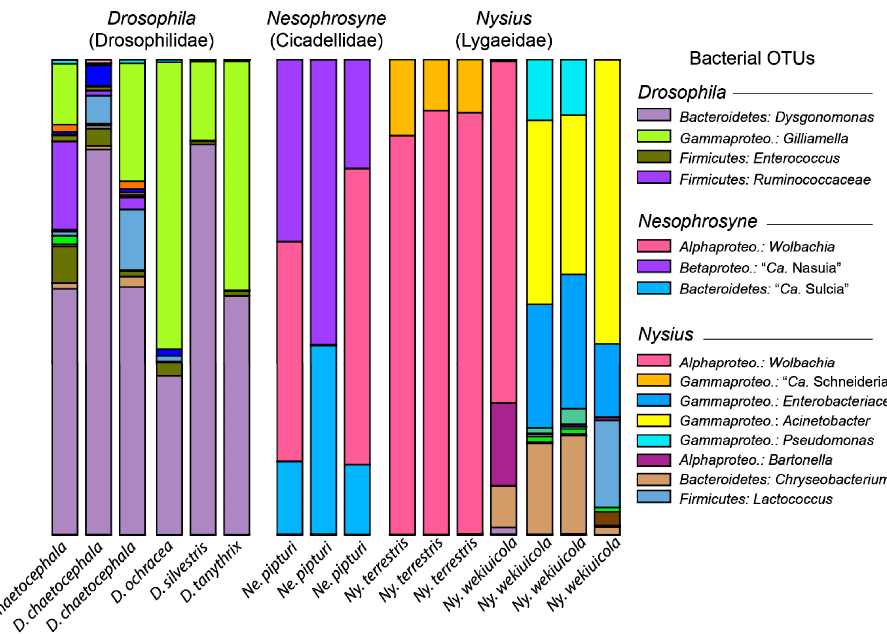
Figure 3. Relative abundance of bacterial groups observed in insects with different feeding behaviors. Different colors represent various bacterial Operational Taxonomic Units (OTUs) present in the corresponding samples. Note: Illustrative colors are distinct to each insect host microbiome community and only the most abundant bacterial taxa are included in the legend. Some taxonomic names (e.g., Betaproteo . = Betaproteobacteria ) have been abbreviated.